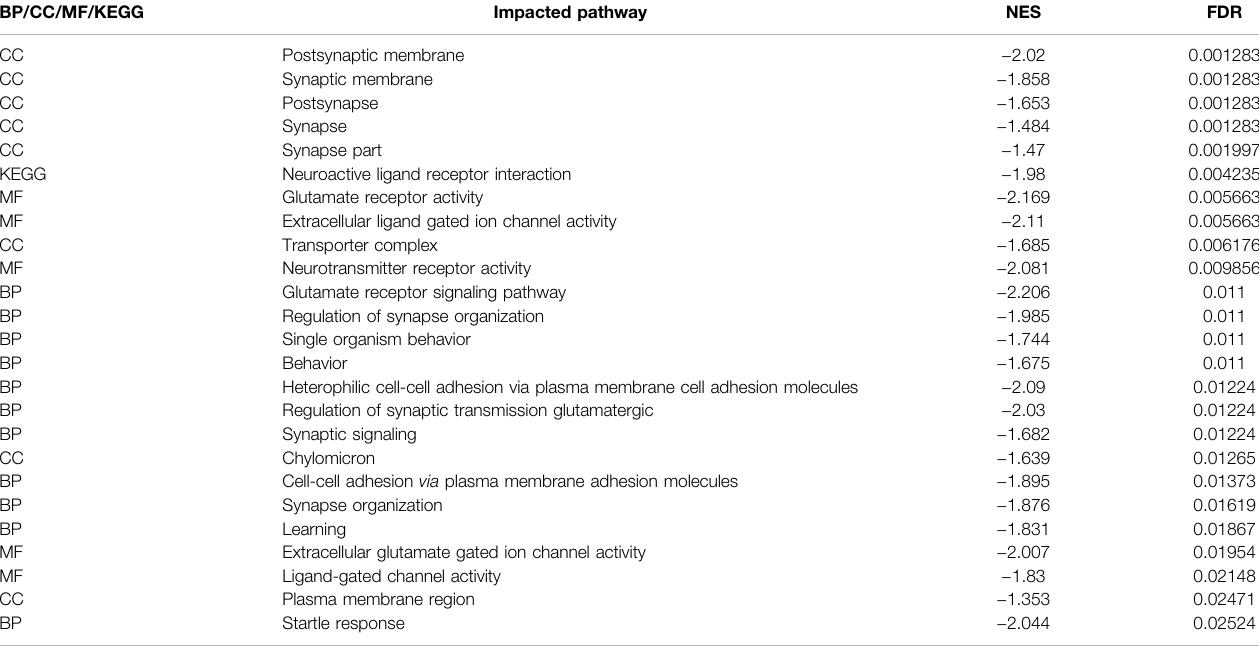
TABLE 5| Top25ImpactedPathwaysobtainedusing GeneSet Enrichment Analysis(GSEA)basedonNormalizedEnrichmentScore(NES)andFalseDiscoveryRate (FDR) using the web tool available at http://adsn.ddnetbio.com/ BP/CC/MF/KEGG